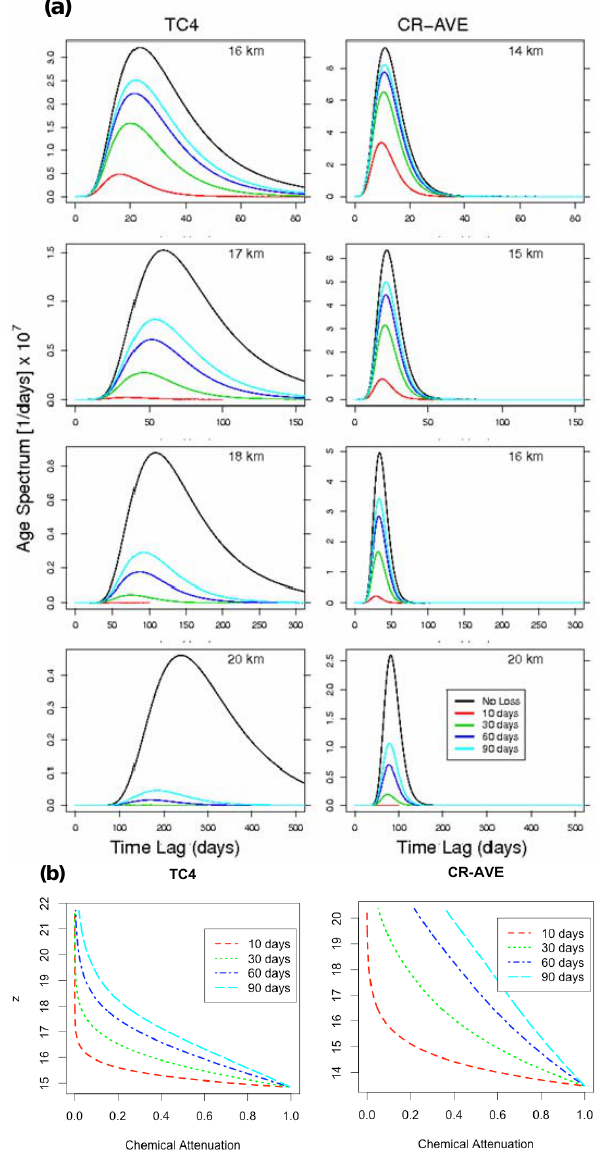
Fig. 10. (a) Age spectra for species with different lifetimes, in Northern summer (TC4) and winter (CR-AVE). (b) Surviving fraction of gases transiting the TTL, plotted versus altitude, for different lifetimes within the TTL.